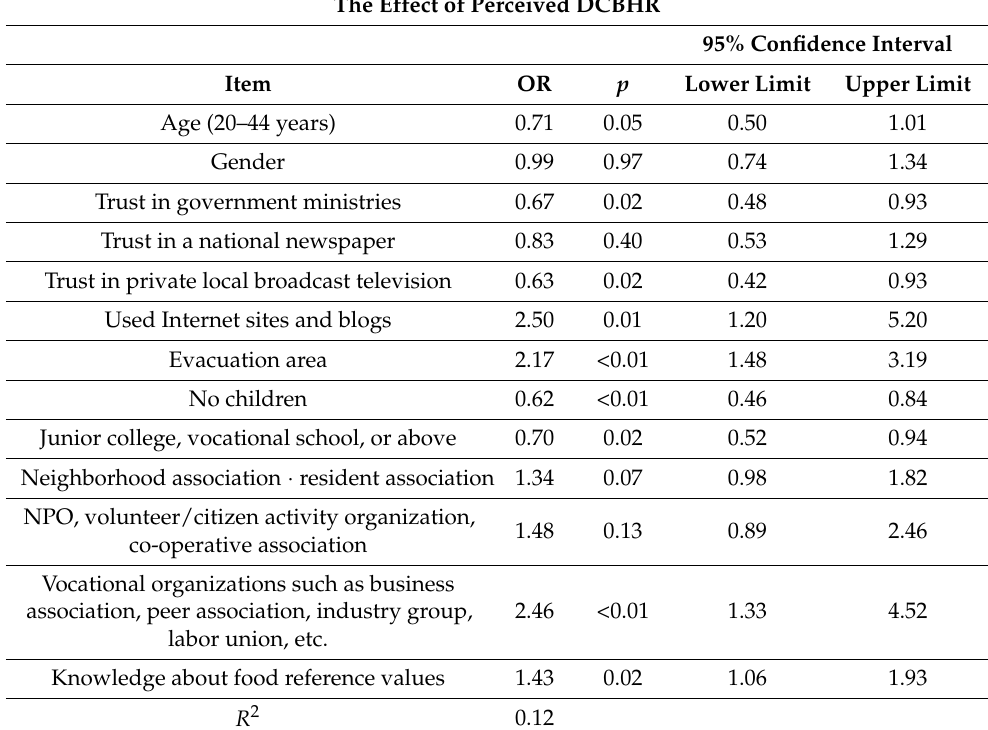
Table 6. Results of the multivariable logistic regression analysis with the presence or absence of the effect of perceived DCBHR as the objective variable and trusted source of information and media consumed as the explanatory variables. ( n =